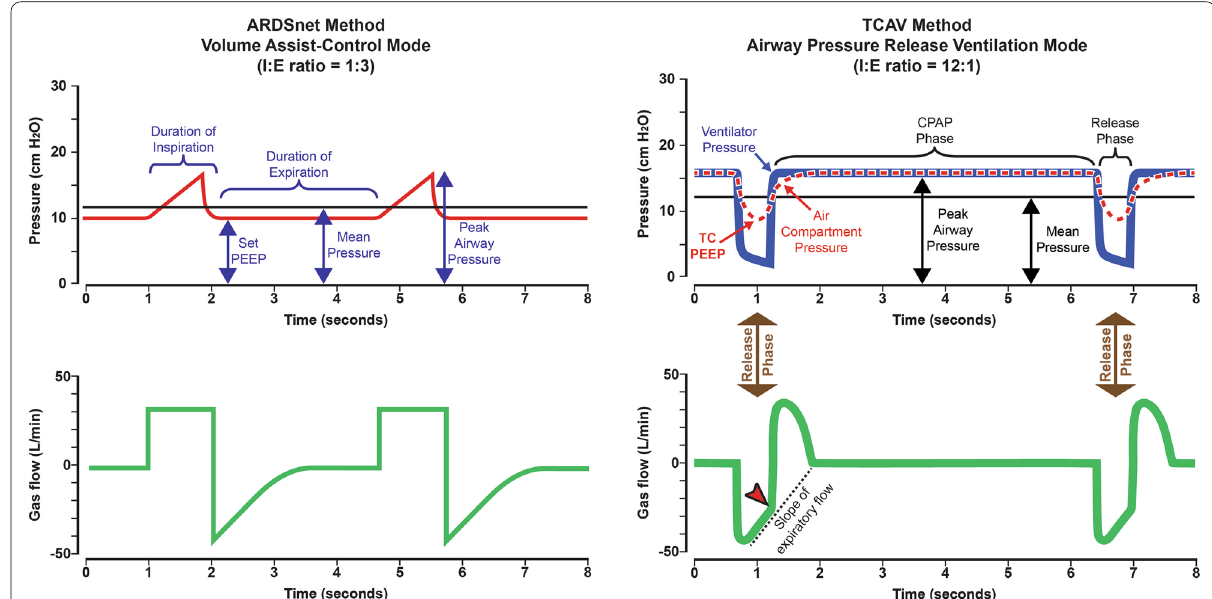
Fig. 4 The ARDSnet method using the volume assist‑control ventilation mode (left) has an I:E ratio of 1:3, which directs a short inspiration and a long expiration, and PEEP is arbitrarily set. Conversely, the TCAV method (right) has an I:E ratio of 12:1, which directs a long inspiration (CPAP phase) and a short expiration (release phase), not allowing the lung to fully depressurize and resulting in a time‑controlled PEEP (TC‑PEEP, red dashed line). Time controlled‑PEEP (TC‑PEEP) is adaptive (not arbitrary) because it is determined in real‑time according to compliance, which is measured in the preceding breath by the slope of the expiratory flow curve (Slope FE ) (red arrowhead on right) (Fig.